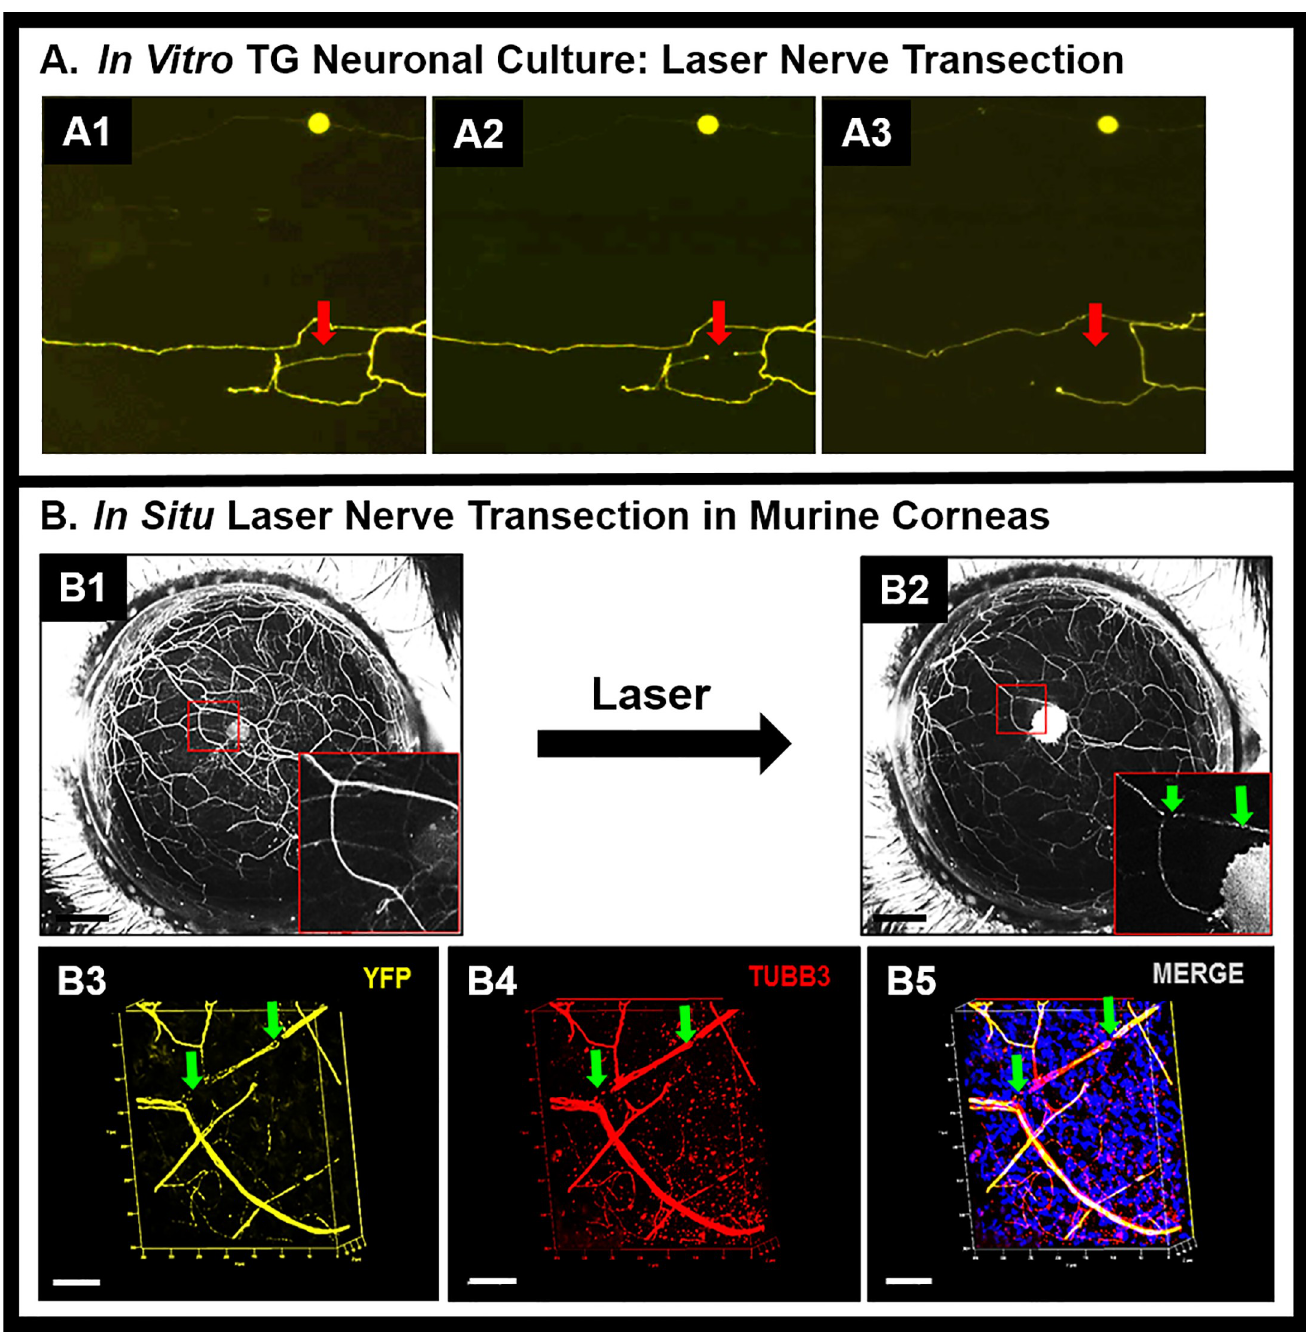
Fig 3. (A) In vitro neurite transection . Intact neurite (A1), transected neurite (A2), and disrupted neurite (A3) in TG neuronal cell culture. Red arrows show location of laser ablation. (B) In situ nerve transection. In vivo stereofluorescent images of corneal nerve before (B1) and after (B2) laser transection (inset: a dichotomously branching nerve trunk showing the ablation site that is marked with green arrows). (B3-B5) Confocal fluorescent microscope images of corneal whole mounts showing discontinuity in YFP fluorescence at the site of laser ablation (B3). Immunostaining for beta-III tubulin shows corresponding discontinuity in the nerve trunk (B4); thus confirming structural discontinuity in the nerve trunk (B5). White scale bars in Panels (A1- A3): 250 μ m; Black scale bars in panels (B1-B2): 500 μ m; White scale bars in Panels (B3 –B5): 50 μ m.